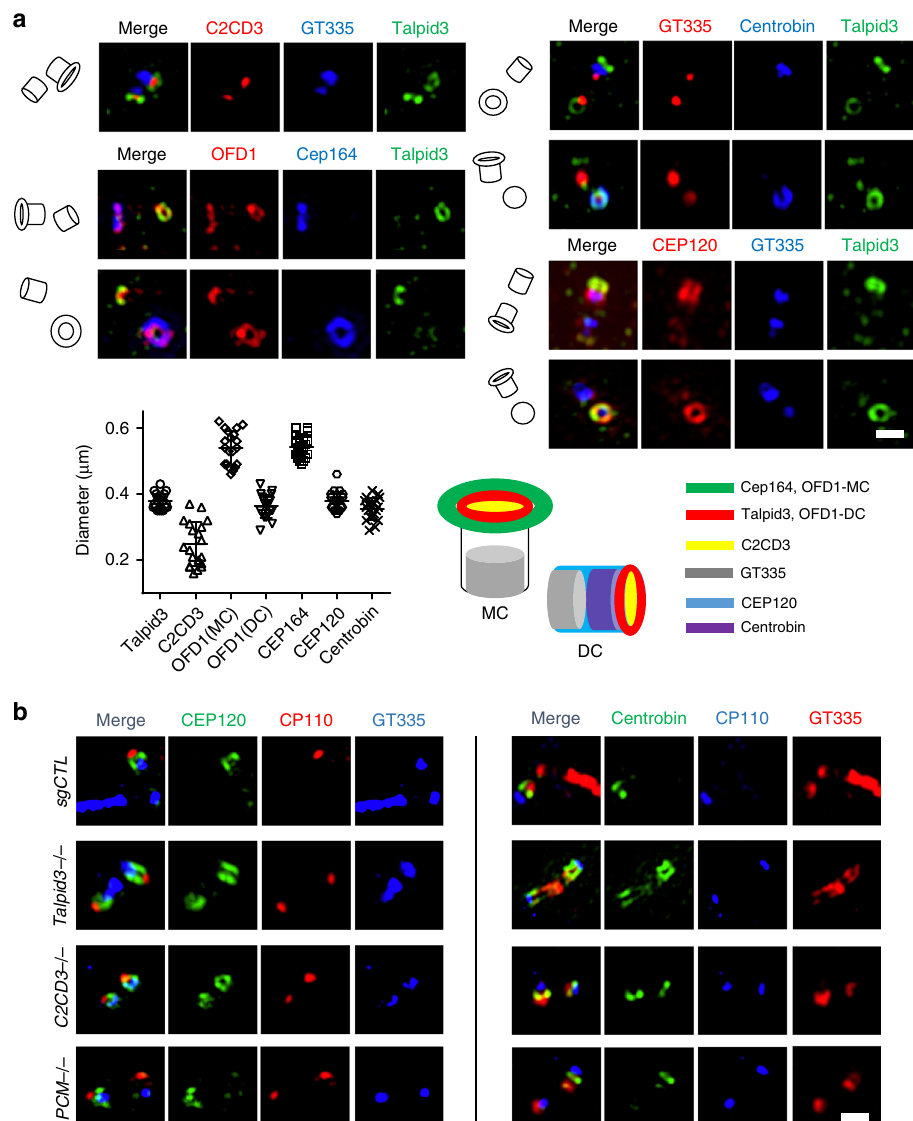
Fig. 6 Topography of distal and daughter centriolar proteins. a Growing RPE1 cells were stained with the indicated combinations of antibodies and visualized using structured illumination microscopy (SIM). Bottom left: diameter of the Talpid3/C2CD3/OFD1 complex, DCPs, and DA protein, CEP164 ( N = 20). Cumulative data from two independent experiments are shown. Bottom right: schematic representation of the centrosome illustrates the localization of Talpid3/C2CD3/OFD1 complex, DCPs, and DA protein, CEP164. b Localization of CEP120 and Centrobin was examined in control, Talpid3 − / − , C2CD3 − / − , and PCM1 − / − cells using SIM. Cells were serum-starved for 24 h and then visualized with indicated antibodies. Scale bars = 0.5 μ